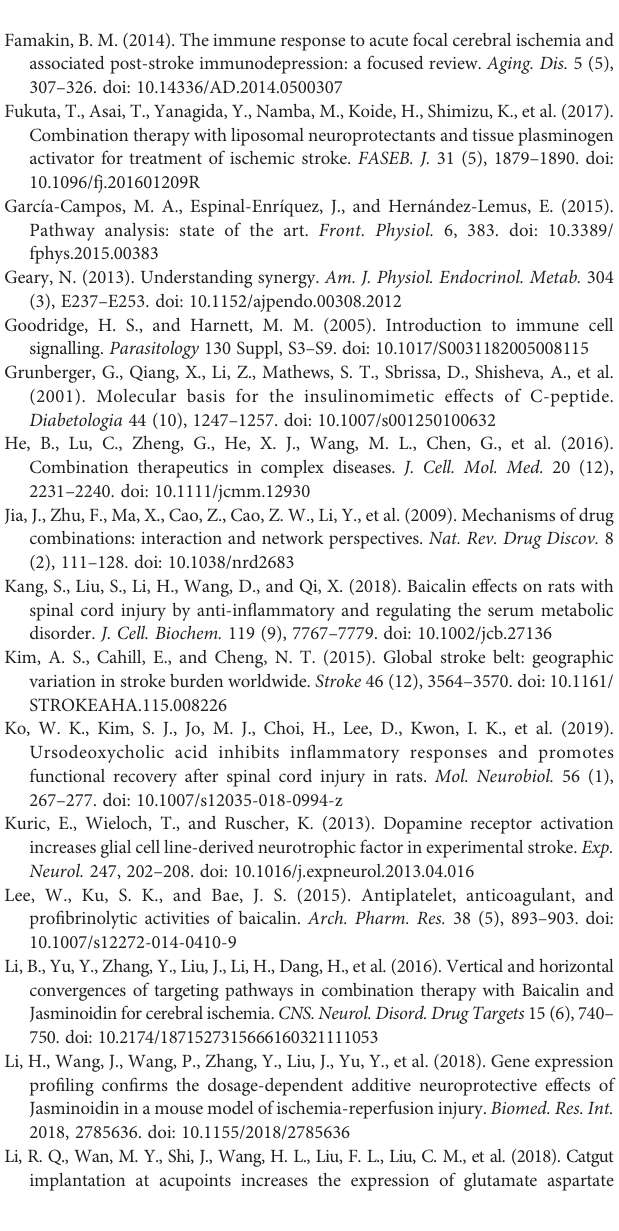
SUPPLEMENTARY FIGURE 1 | The enriched pathways of BA vs CM, JA vs CM, UA vs CM, BJ vs CM, JU vs CM. SUPPLEMENTARY FIGURE 2 | The “ Development_Role of IL-8 in angiogenesis ” pathway was shared by BJ and JU groups. Differentially expressed genes regulating by JU were labeled as thermometer-like fi gures, up-ward red thermometers indicate up-regulated signals, with height corresponding to signi fi cance level. The map legend can be viewed at http:// pathwaymaps.com/pdf/